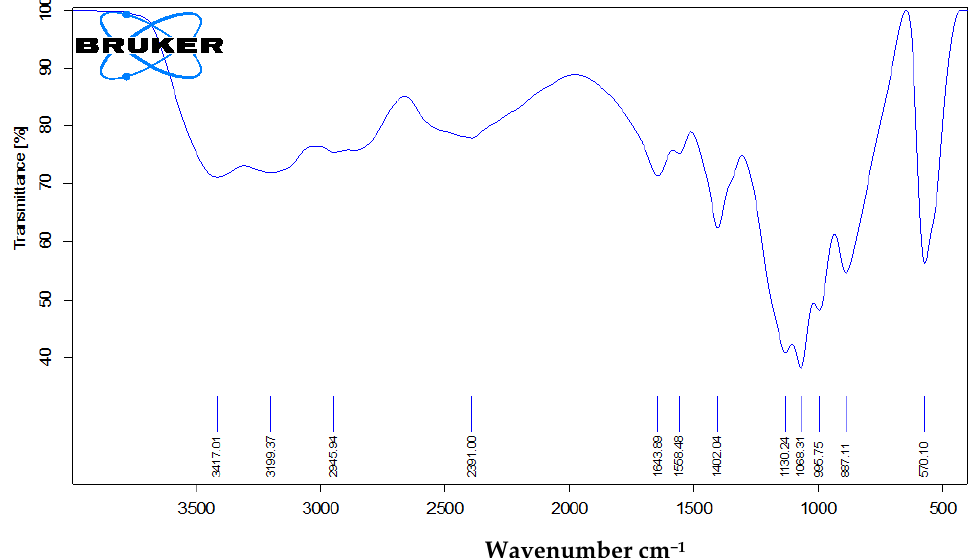
Figure 4. Fourier Transformer Infrared (FT–IR) spectrum of nanocalcium phosphate.